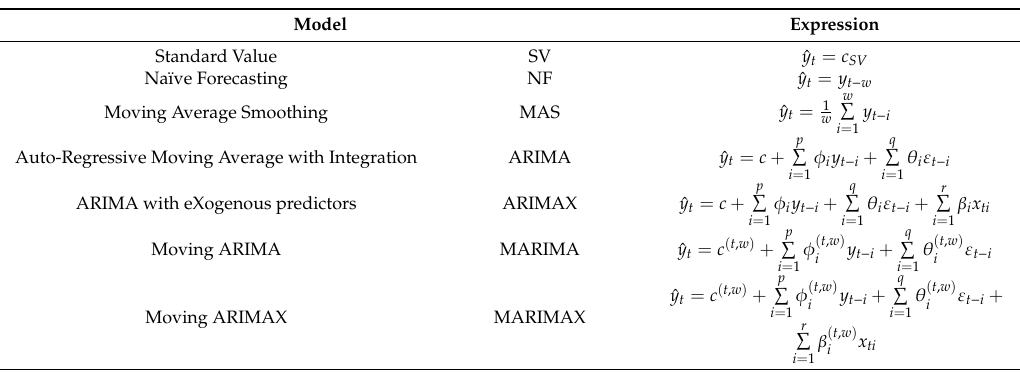
Table 2. Stochastic